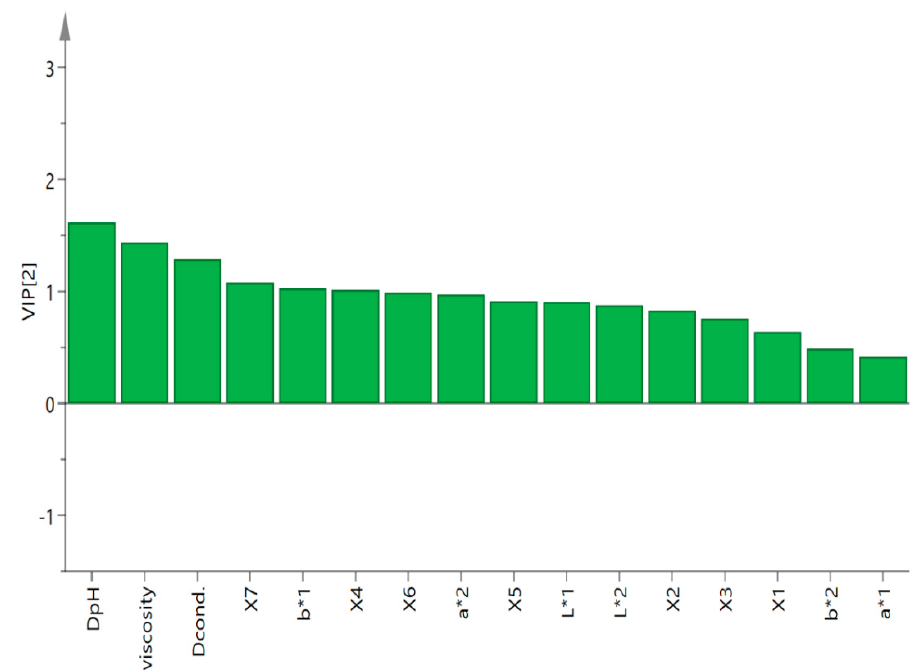
Figure 5. The variable importance to projection (VIP) of the partial least squares regression (PLSR) analysis of total sensory evaluation scores and physical–chemical parameters.